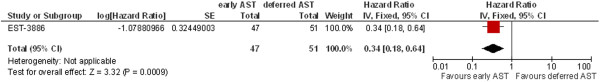
Cancer-specific survival. EST-3886, median follow-up 11.9 years; AST, androgen suppression therapy. (This figure should be published online only).